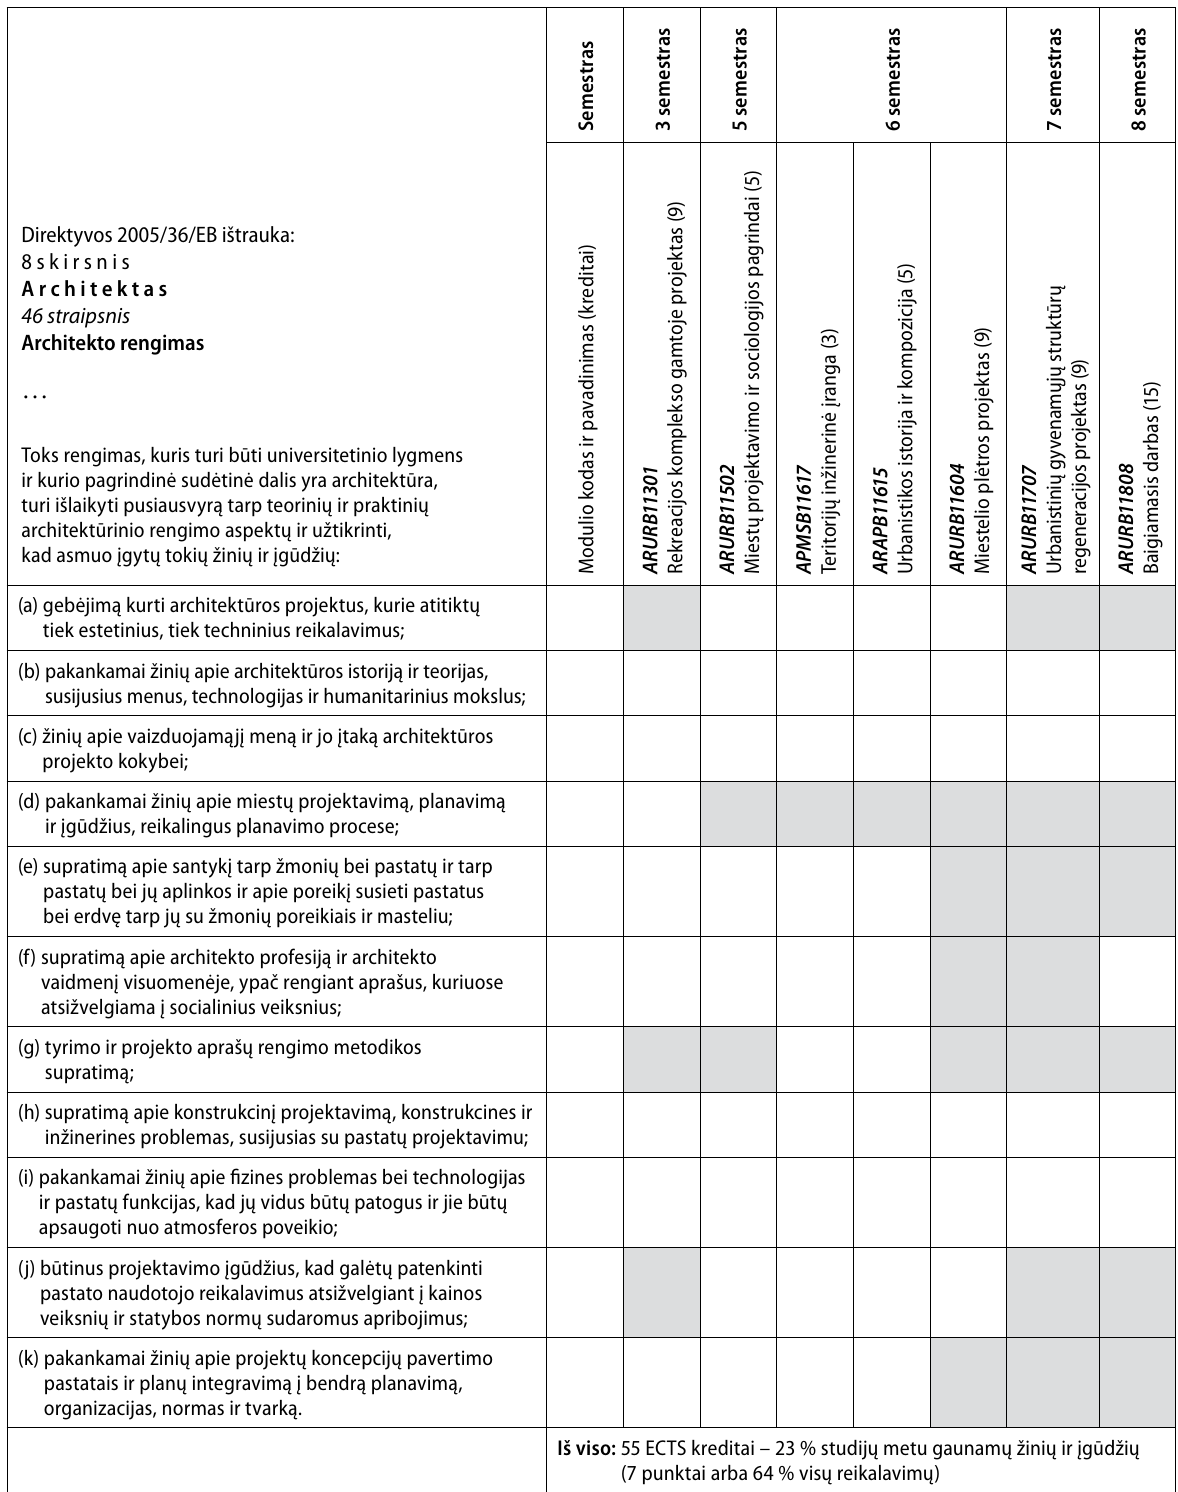
Table 2. Compliance of courses on urban design basics taught under the first cycle programme in architecture offered at VGTu af with the requirements of the Eu Directive 2005/36/EC